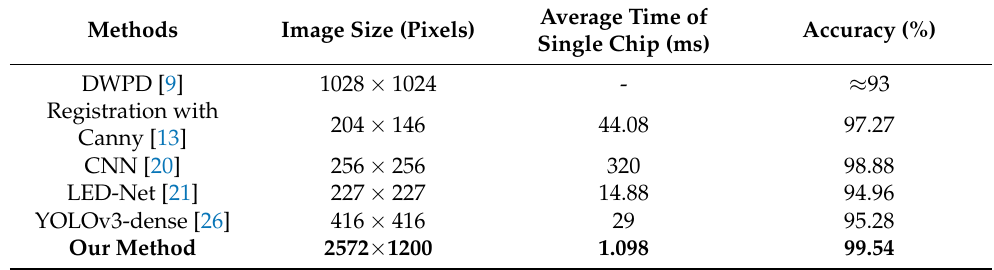
Table 3. Comparison to other